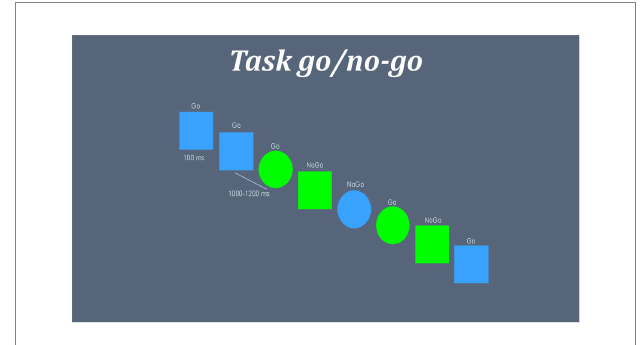
FIGURE 1 Representation inhibitory task go/no-go. Blue squares and green circles were set as “GO” targets, while green squares and blue circles were set as “NO-GO” targets. Inter stimuli interval were a random time between 1,000 and 1,200 ms. Stimulus were presented in screen during 100 ms followed by a fixation cross “+.” GO and NO-GO trials were presented